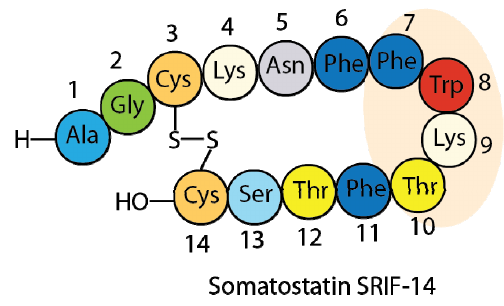
Figure 1. Amino acid sequence of